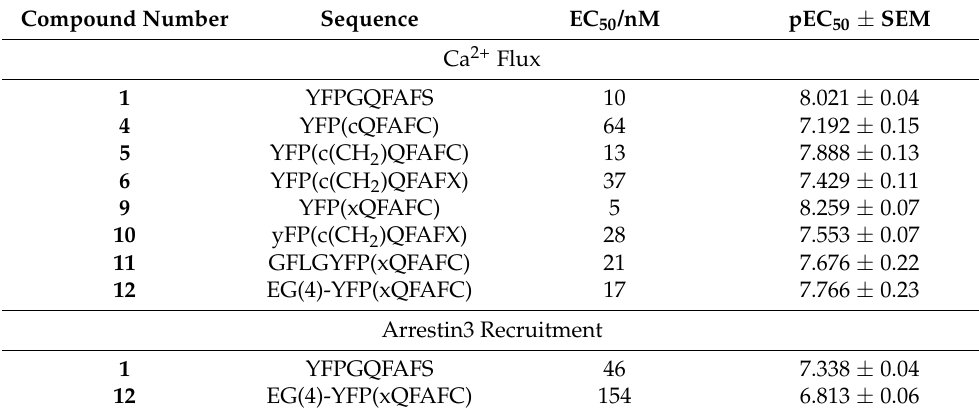
Table 4. Activity of chemerin-9 derivatives. All data were obtained from at least two independent experiments performed in triplicates (Ca 2+ flux) or quadruplicates (arrestin recruitment). Data were normalized to the top and bottom values of the chemerin-9 curve, and nonlinear regression was performed with a three-parameter curve fit in GraphPad Prism 5. X = Homocysteine, x = D-homcysteine. Compound